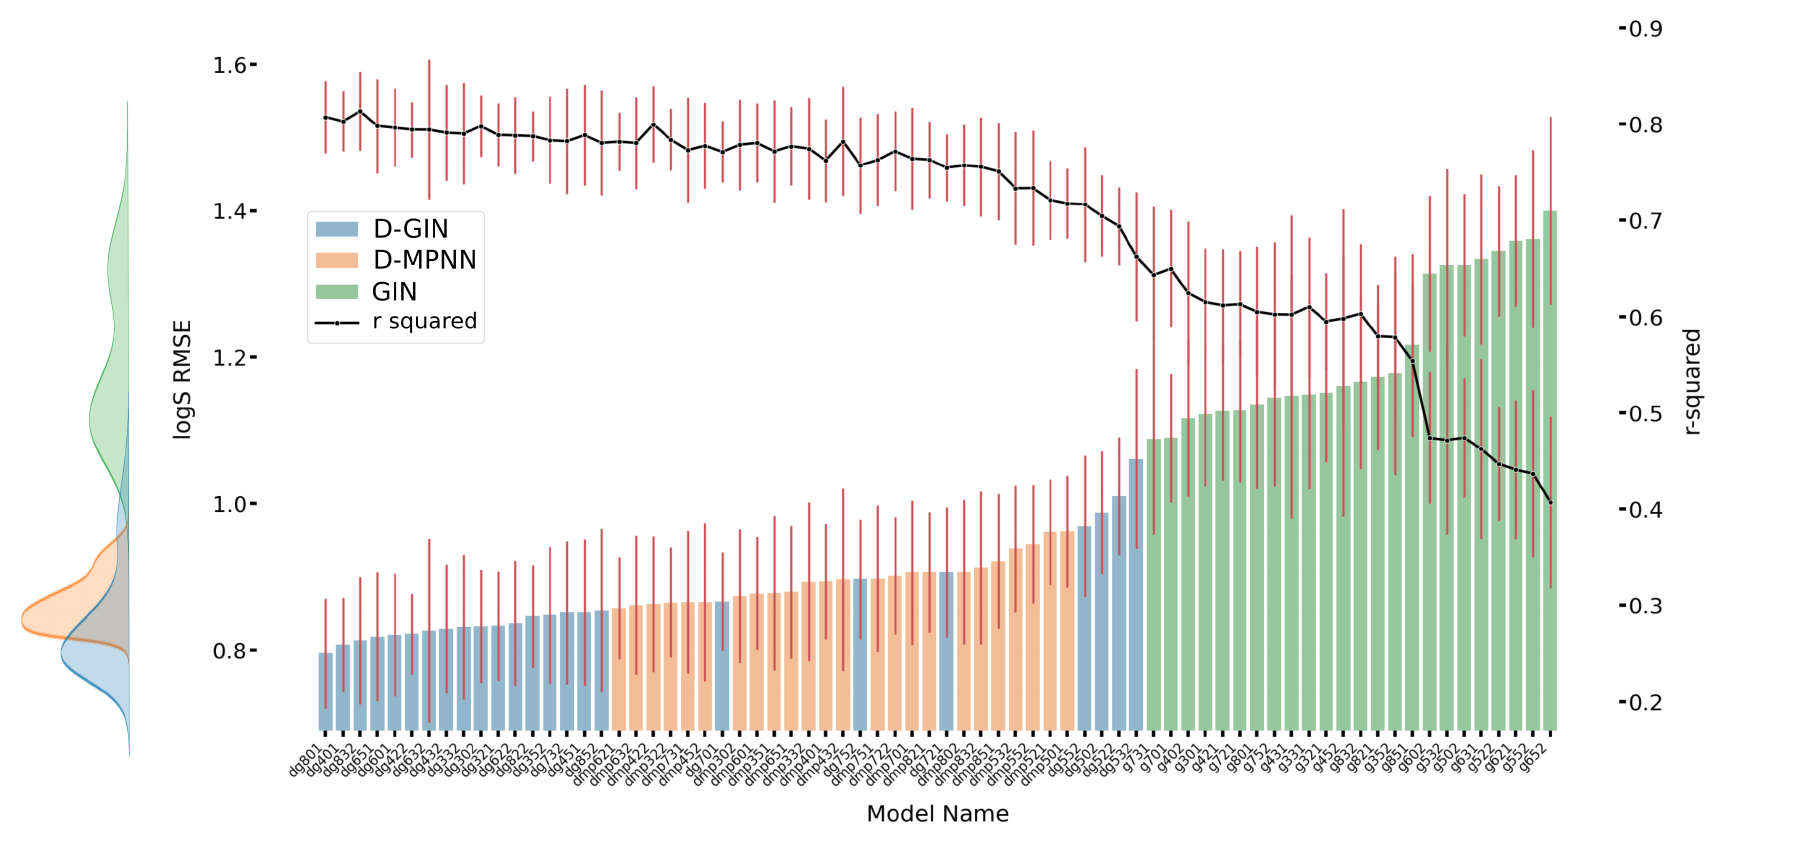
Figure A3. The first y-axis specifies the logS RMSE and the secondary x-axis the corresponding r 2 values for each GNN model. The D-GIN is colored blue, the D-MPNN orange and the GIN green. Each of the boxes represents one different model run. The kernel density of each model is shown on the very left side. The red lines correspond to the 95% confidence intervals. The model names are a combination of model type (D-GIN, GIN, D-MPNN), training approach and featurization type-a detailed description of each model name can be found in Tables A8–A19 in the Appendix